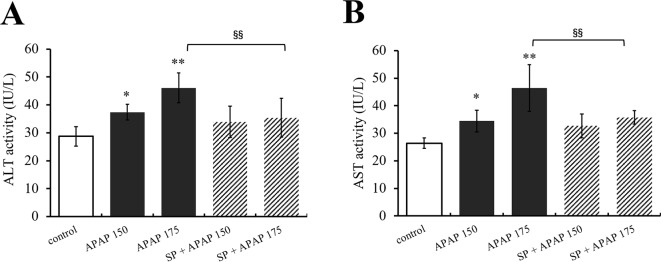
Inhibiting JNK ameliorated APAP-induced liver toxicity respect to ALT and AST. (A) Change of ALT activity under different dosages of APAP in serum of mice with or without SP600125. (B) Change of AST activity under different dosages of APAP in serum of mice with or without SP600125. Values represented as means ± SD, n = 6. *Represents statistical differences caused by APAP. §Represents statistical differences caused by SP600125 under the same dose of APAP. 0.05 > P > 0.01 (*). P < 0.01 (**, §§).